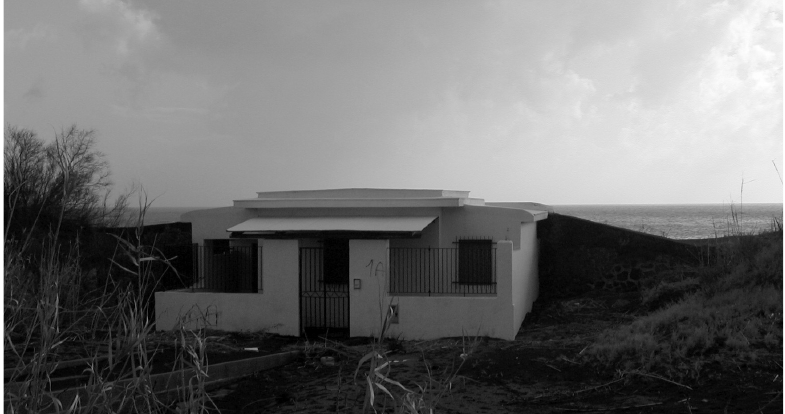
Fig. 13. View of the western side of building #6. The picture was taken a few days after the 2002 tsunami. Building #6 is a Coastaguard station on the beach of Scari (Stromboli – Fig. 6). As clearly shown by the picture, the seaward side of the building is totally “covered” by a coastal dune. The PTVA-3 Model attributed to building #6 an “average” RVI